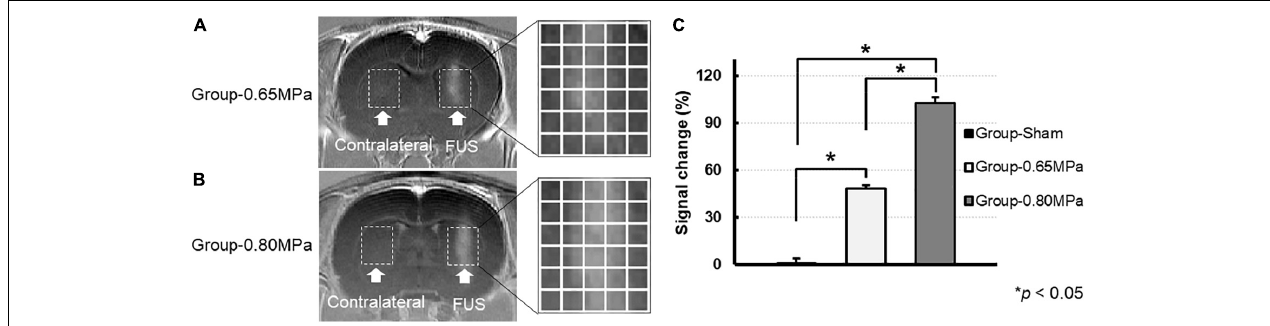
FIGURE 2 | Magnitude of BBBD according to the MR signal change. T1-weighted contrast-enhanced images 5 min after the FUS were used to verify the opening of the BBB for group-0.65 MPa (A) and group-0.80 MPa (B) . The white dotted lines represent the ROIs in sonication (FUS) and contralateral regions (C) . The enhanced signal after the FUS sonication in ROIs accessed by each group. * p <